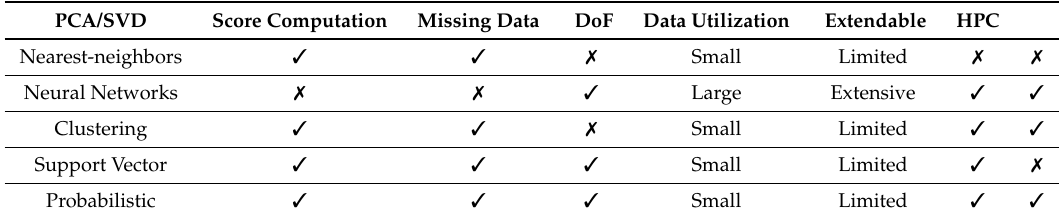
Table 3. Comparison of attributes of neural network (deep learning)-based approaches with standard nearest neighbor and other